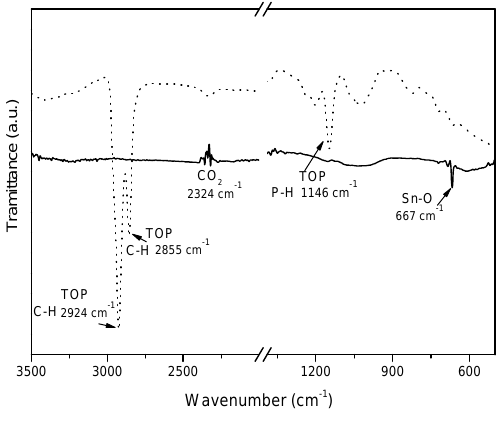
Figure 6. FTIR spectra of the as-deposited (dotted line) and vacuum-annealed (solid line) SnO nanoparticle 2